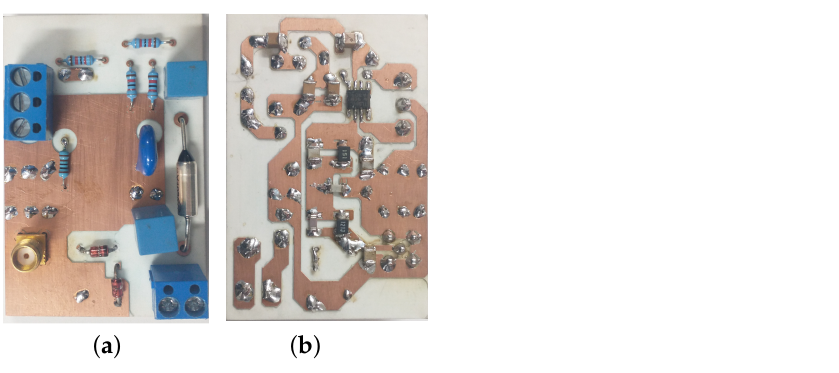
Figure 7. The prototype of the NB–PLC notch coupling circuit. ( a ) PCB top layer. ( b ) PCB bottom